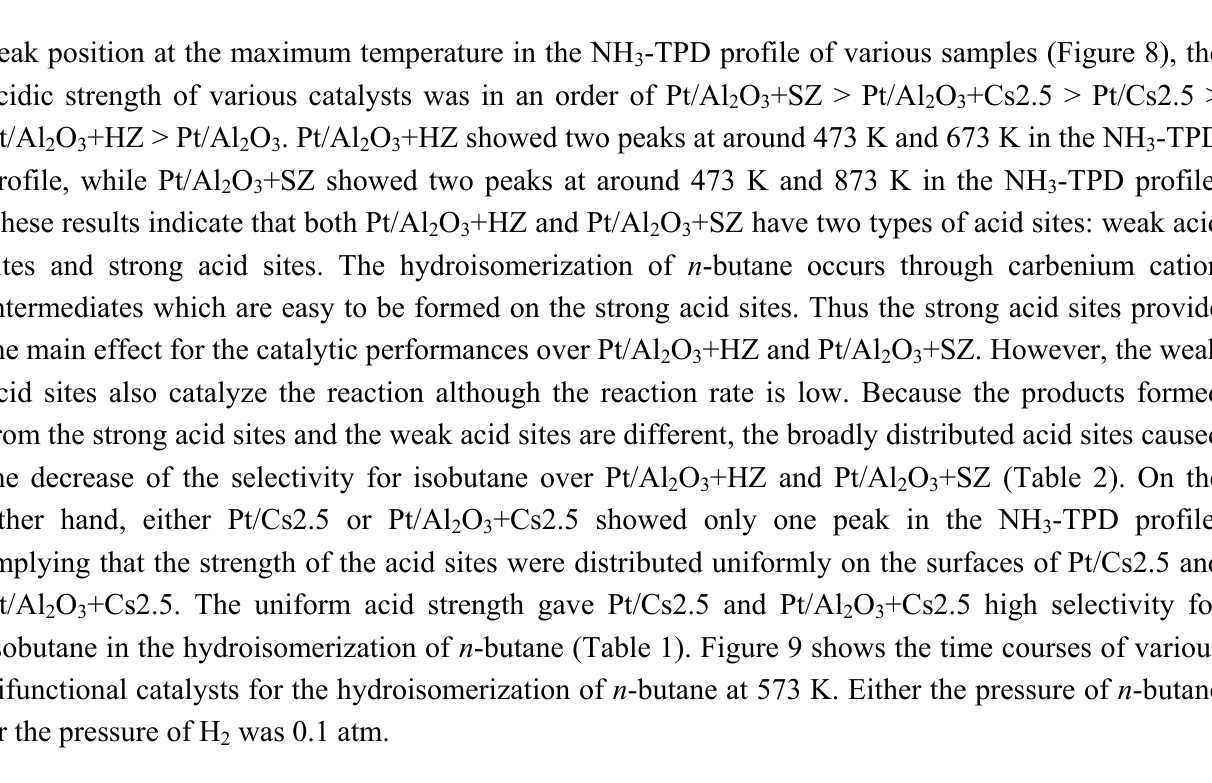
Figure 9. Time courses various bifunctional catalysts for the hydroisomerization of n - butane at 573 K. ( ● ) Pt/Al